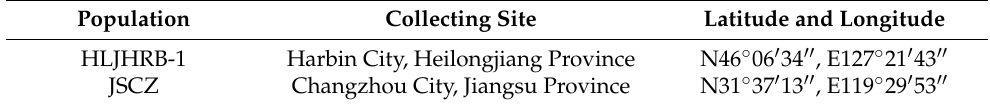
Table 4. Information of wild soybeans used in the experiment.